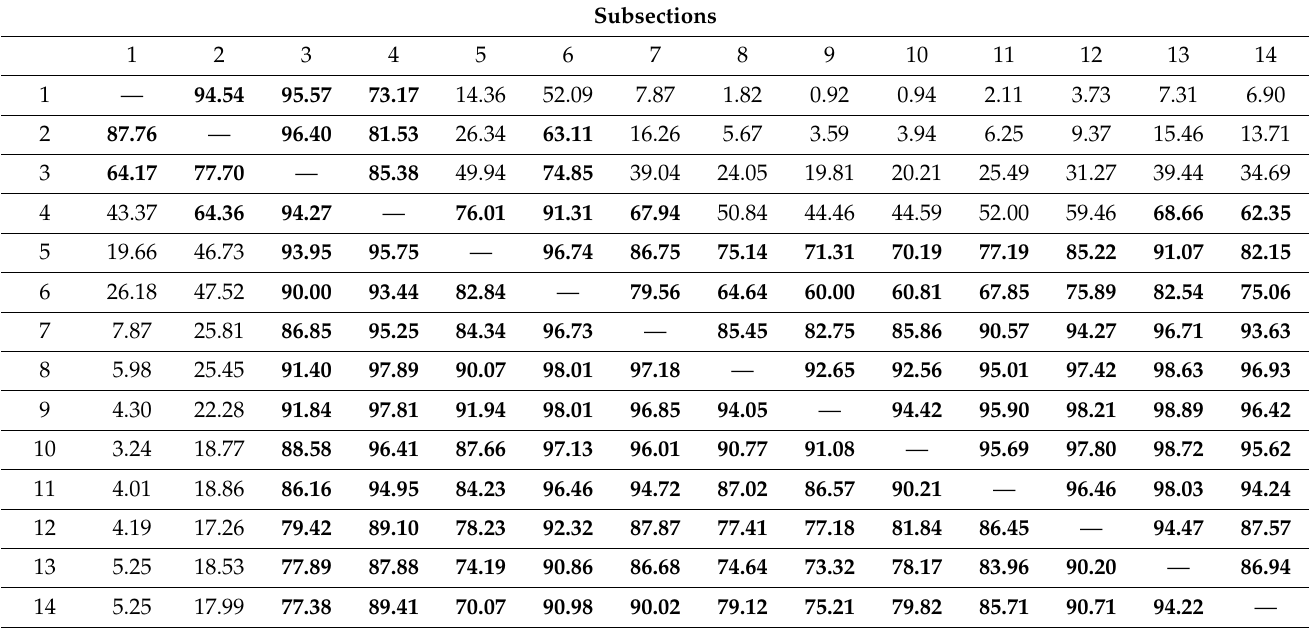
Table 4. Overlap among isotopic niches, estimated in nicheROVER 1.1.0 for different upper beak subsections of Gonatus fabricii . Significant overlap values are in bold . ——not